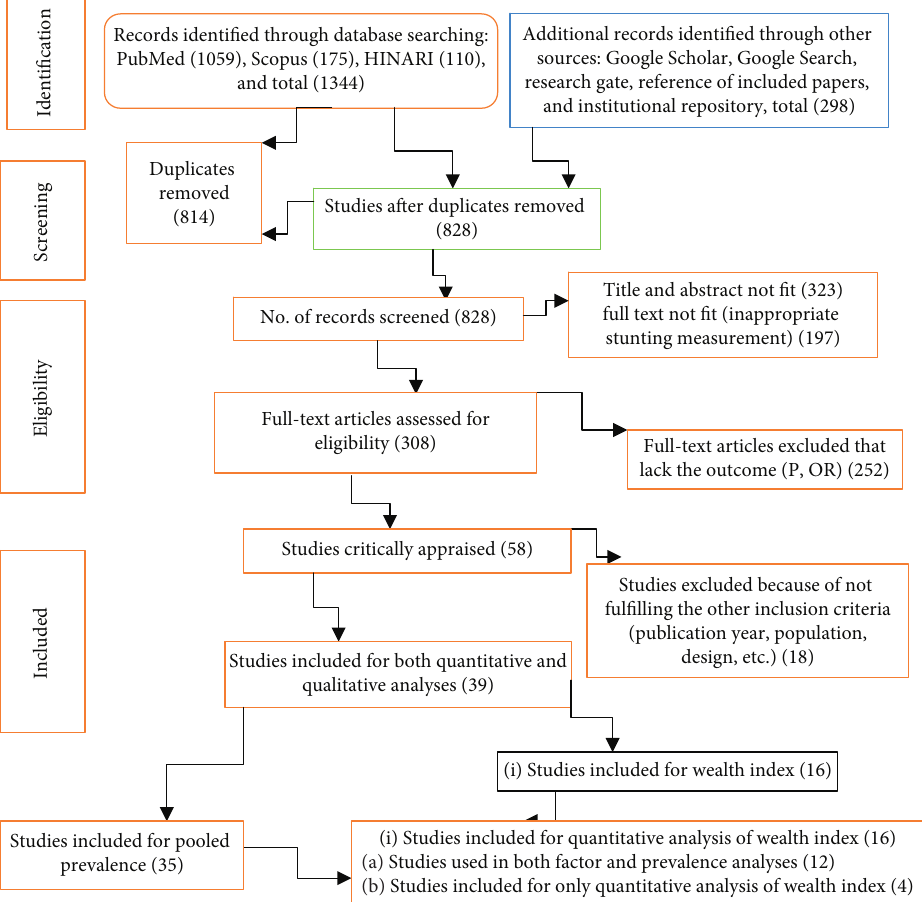
Figure 1: The PRISMA flowchart that indicates study selection and appraisal